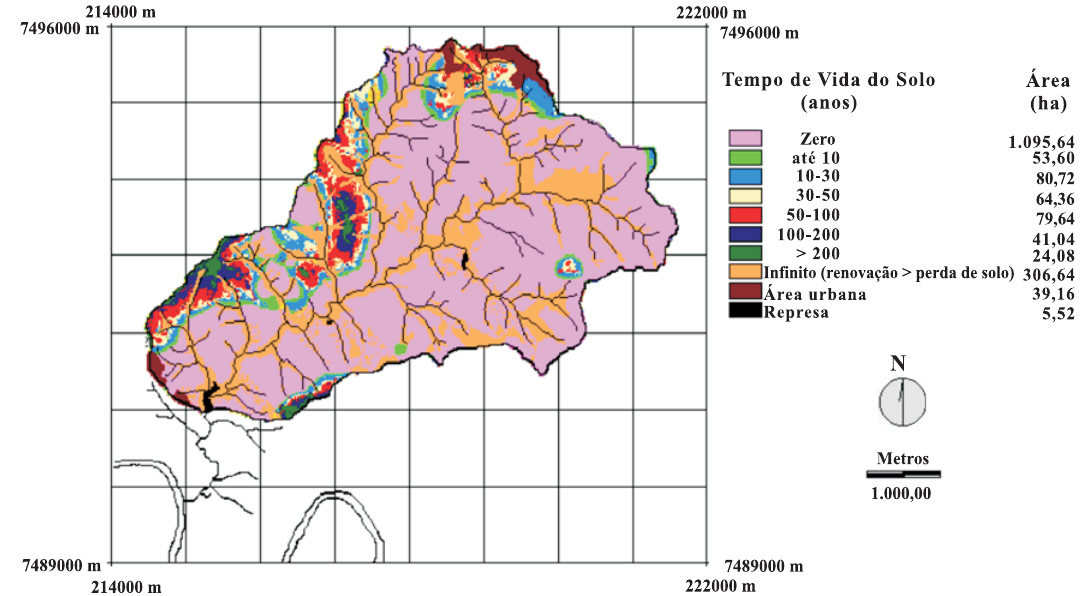
Figura 5. Mapa do tempo de vida do solo (em ano) da área de estudo para a profundidade crítica de 100